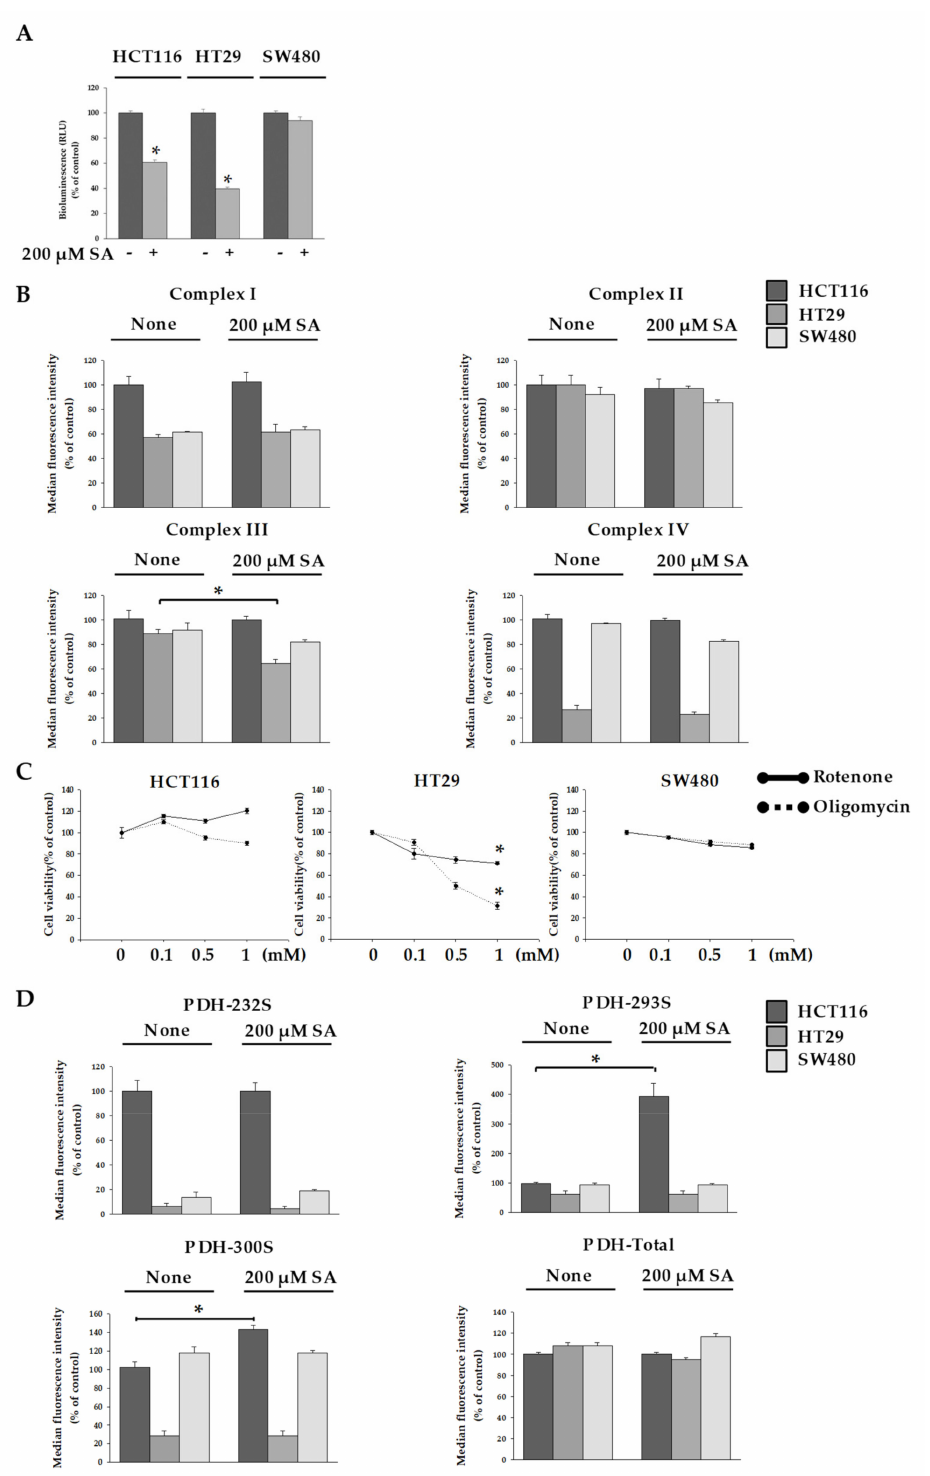
Figure 3. Measurement of electron transport chain (ETC) and pyruvate dehydrogenase (PDH) activity. HCT116, HT29, and SW480 cells were treated with 200 µ M SA for 48 h. ( A ) ATP levels in cells treated with SA treatment compared to untreated control. ( B ) Activity of complexes in HCT116, HT29, and SW480 cells treated with SA was measured. ( C ) Each cell was treated with rotenone or oligomycin on various concentration-dependent for 48 h, and cell viability was analyzed. ( D ) pyruvate dehydrogenase kinase (PDK) levels in the cells were measured to confirm PDH activity. Data are representative values of three independent experiments and expressed as mean ± SD ( n = 3), * p <